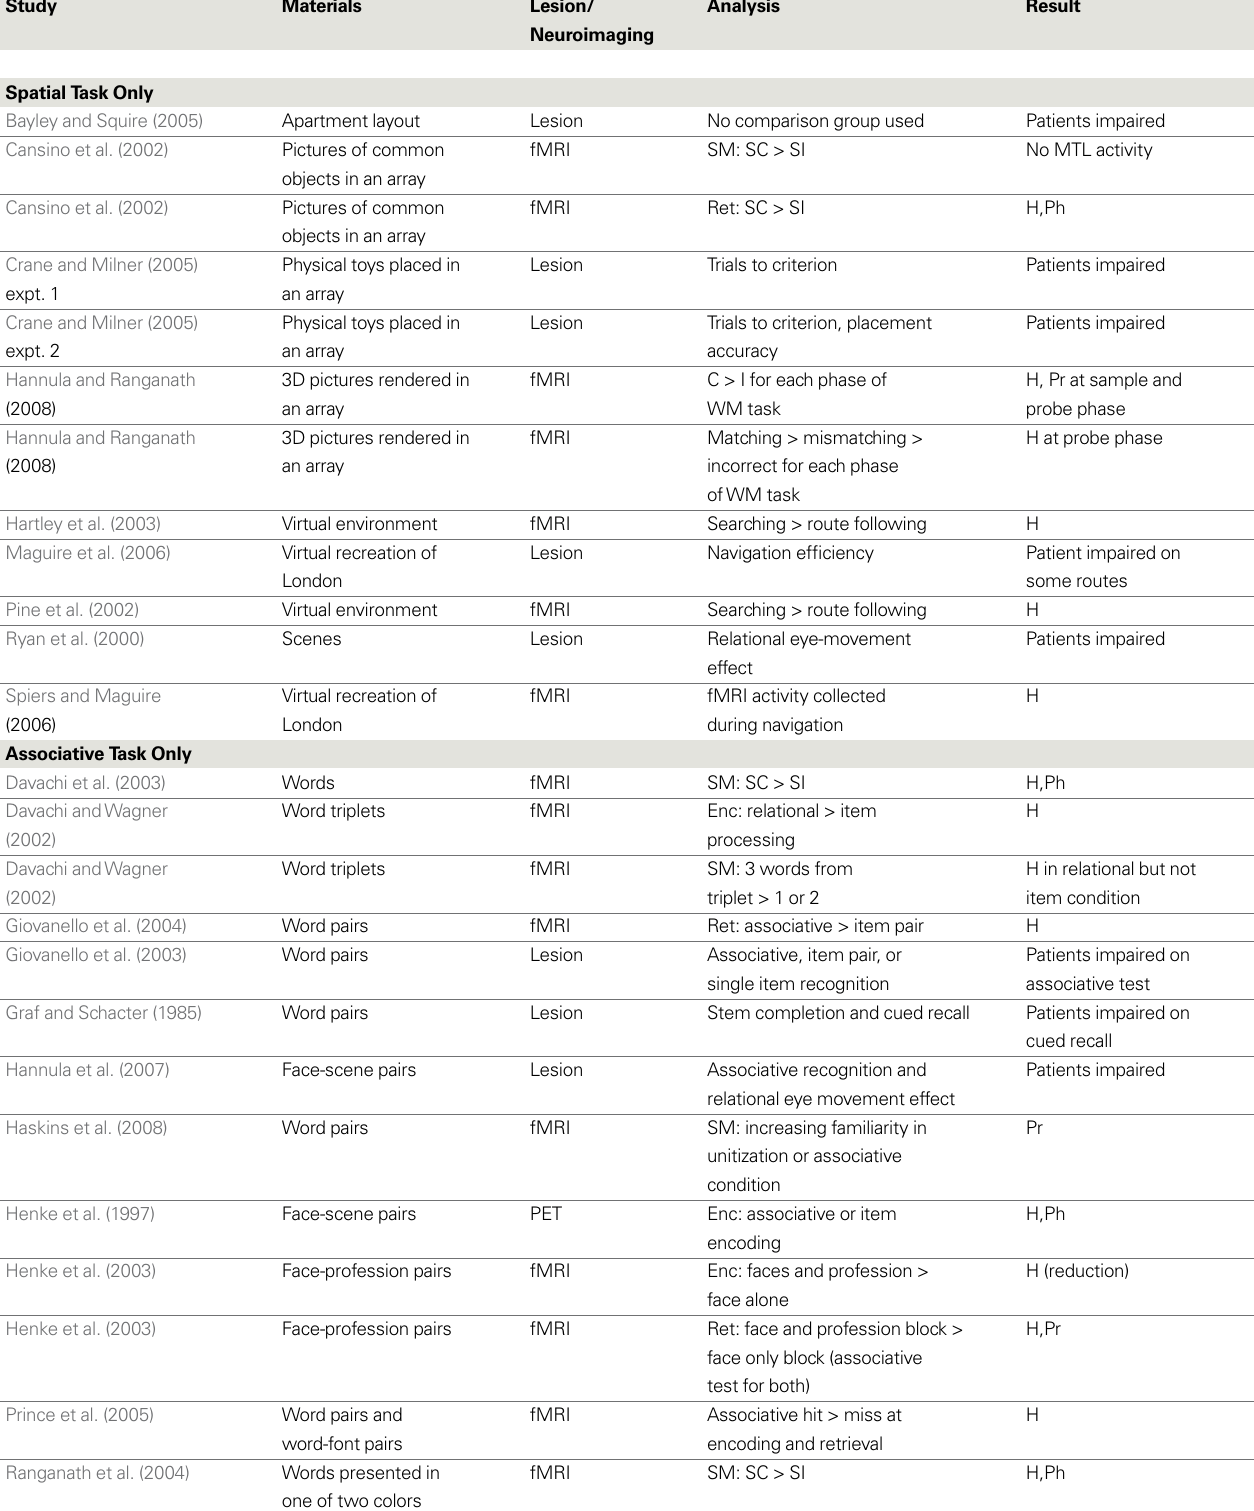
Table 1 | A selection of neuroimaging and MTL lesion studies that tested memory for associations, spatial locations, sequences, or some combination thereof. For neuroimaging studies, the result column lists the active MTL regions for the listed contrast (or reduction in activity as noted).